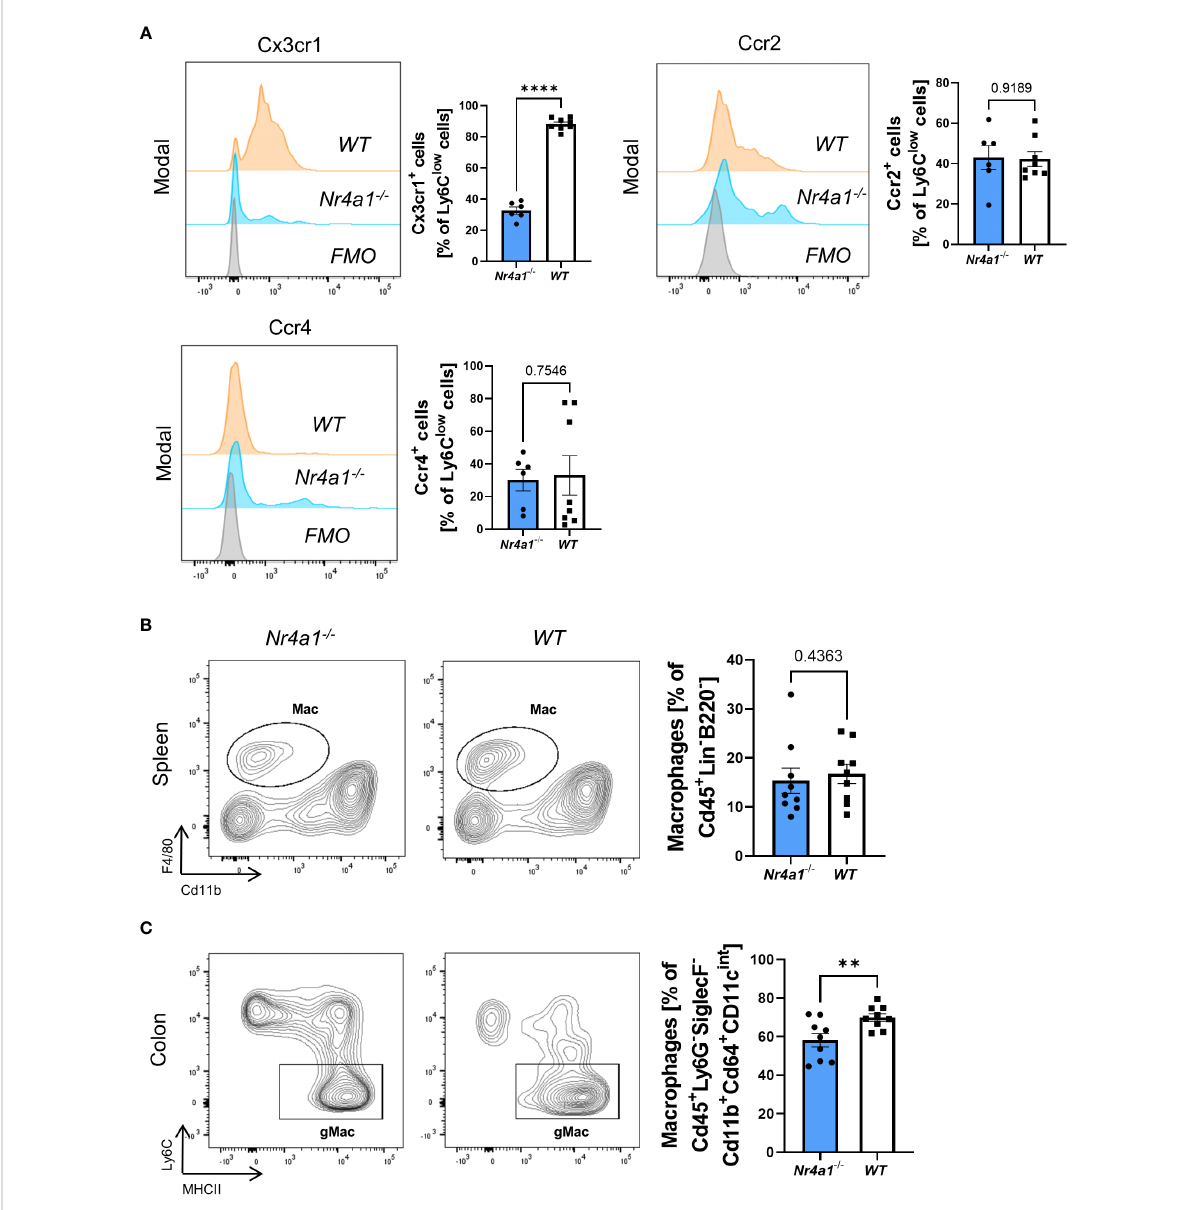
FIGURE 2 Alteration of Cx3cr1 expression on non-classical monocytes and reduction of intestinal macrophages in Nr4a1 -de fi cient mice. (A) Representative histograms of the expression of the chemokine receptors Cx3cr1, Ccr2 and Ccr4 on Ly6C low peripheral blood monocytes (left) and quantitative analysis (right) in Nr4a1 -/- (n=6) and WT (n=8) mice from three independent experiments. (B) Representative (left) and quantitative fl ow cytometry (right) of splenic macrophages gated as described in Supplementary Figure 2A in Nr4a1 -/- (n=9) and WT (n=9) mice. (C) Representative (left) and quantitative fl ow cytometry of viable Cd45 + Ly6G - Cd11b + SiglecF - Cd64 + Cd11c int MHCII + Ly6C - macrophages in the colon lamina propria of Nr4a1 -/- (n=9) and WT (n=9) mice. Three independent experiments, ** p < 0.01, **** p < 0.0001. FMO, Fluorescence Minus One